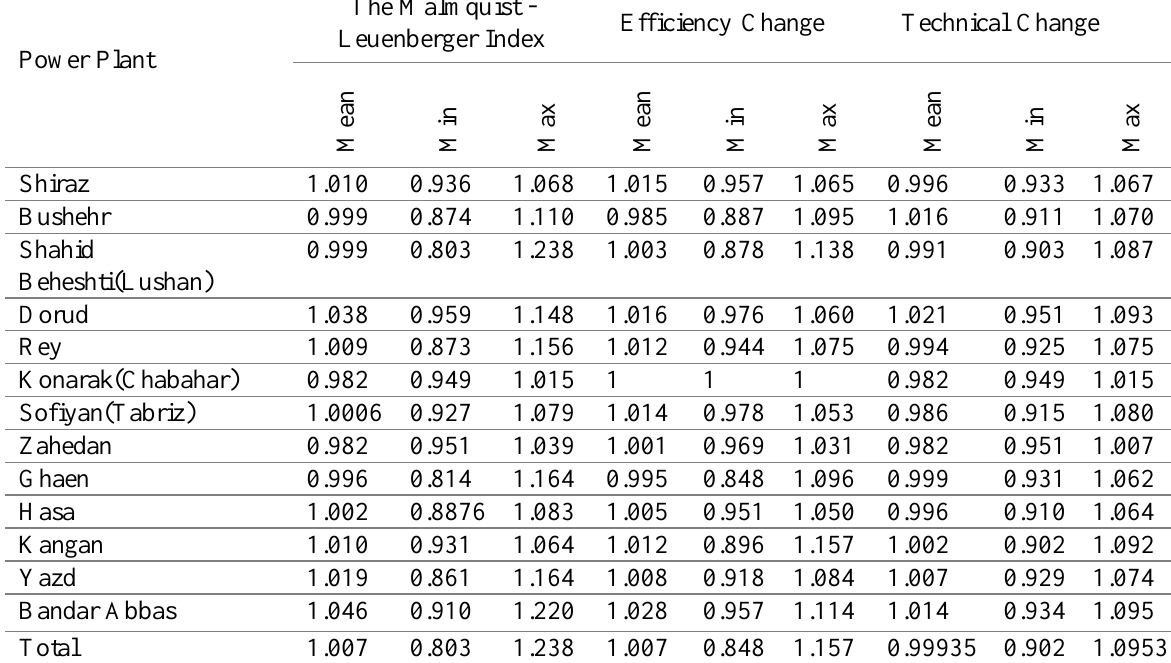
Technical Change Efficiency Change